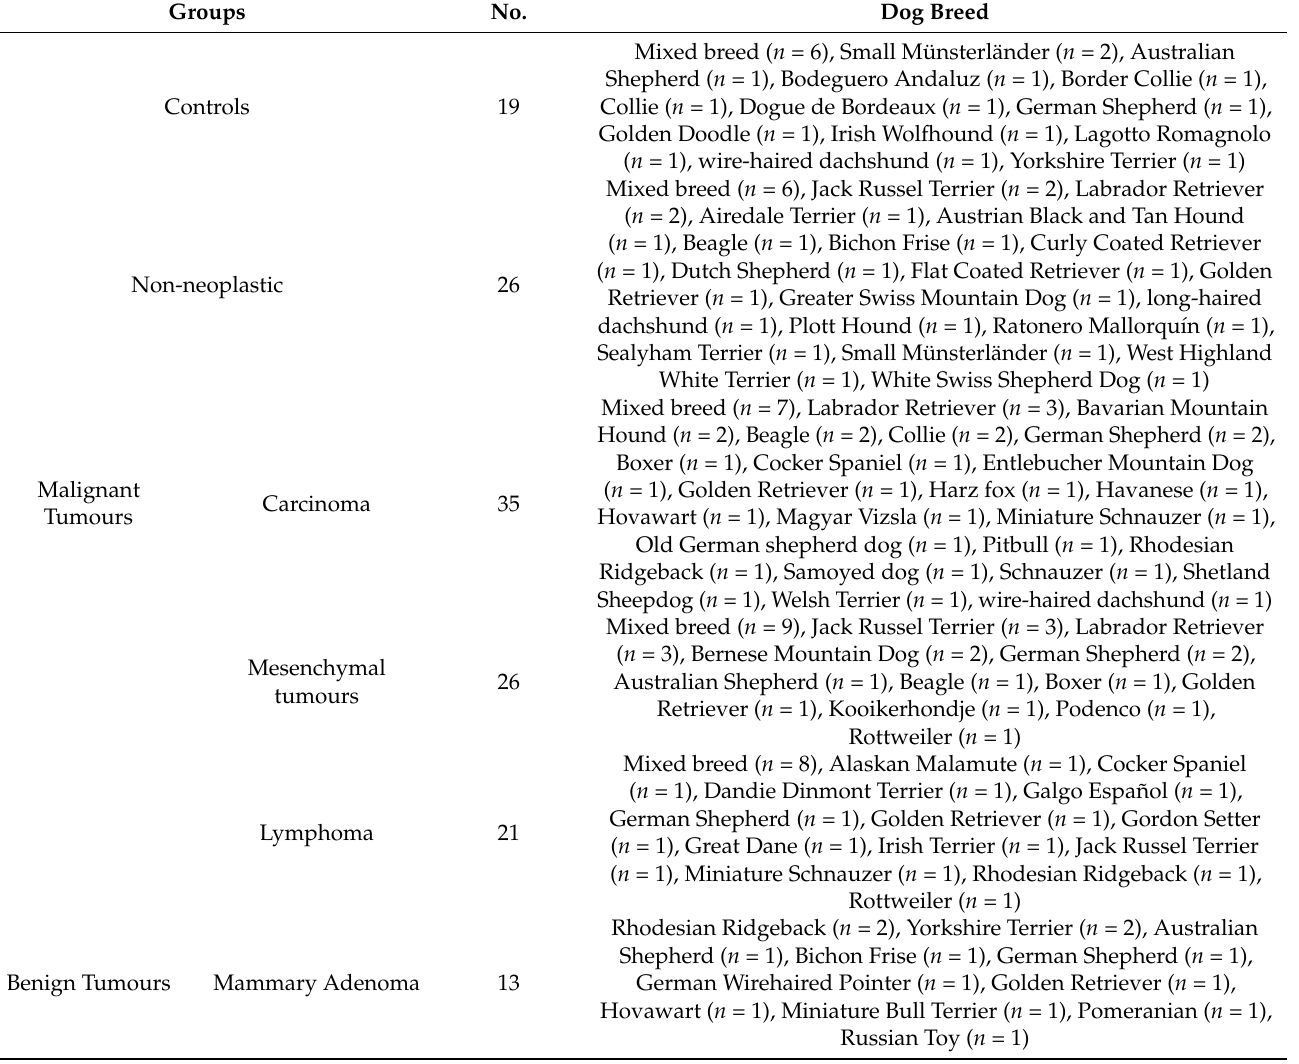
Table 1. Dog breeds of all dogs investigated in this